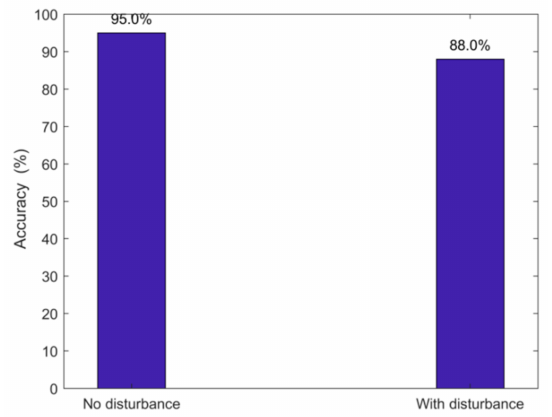
Figure 15. Movement of other people as